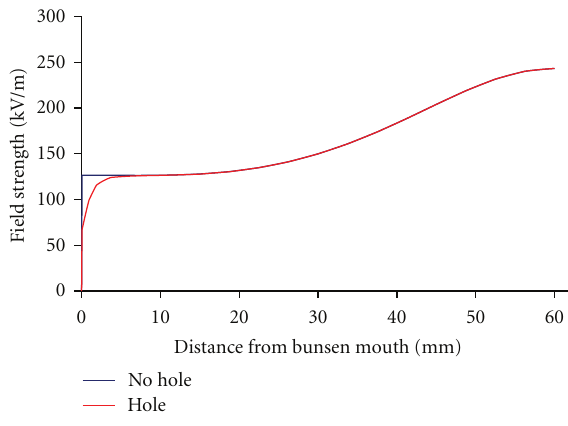
Figure 16: Comparison of the field strength with and without a hole in the bottom plate.